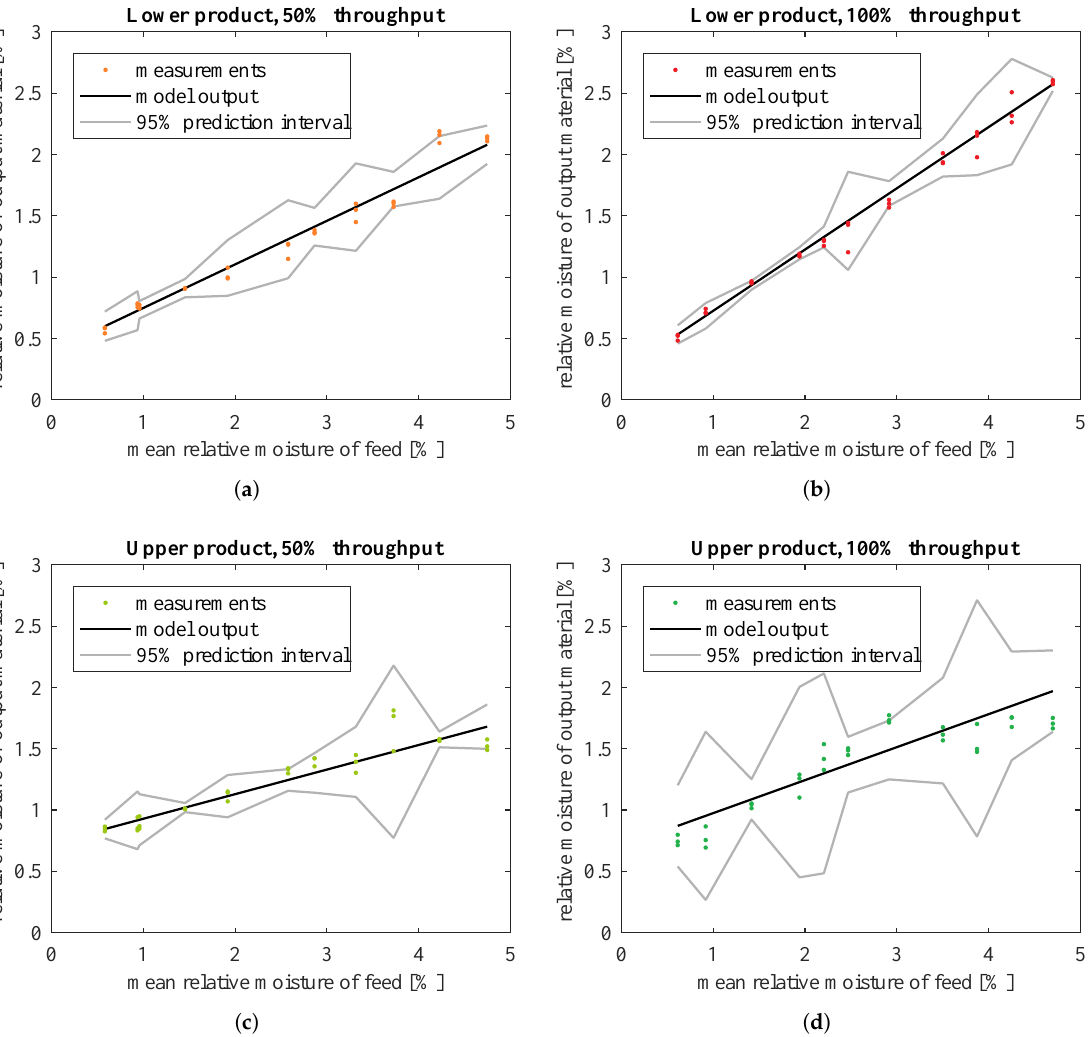
Figure 8. Straight line models fitted to measured moisture of classification products in relation to moisture of input material, separately for different products and different throughput of the screw feeder: ( a ) lower product, 50% of nominal throughput; ( b ) lower product, 100% of nominal throughput; ( c ) upper product, 50% of nominal throughput; ( d ) upper product, 100% of nominal